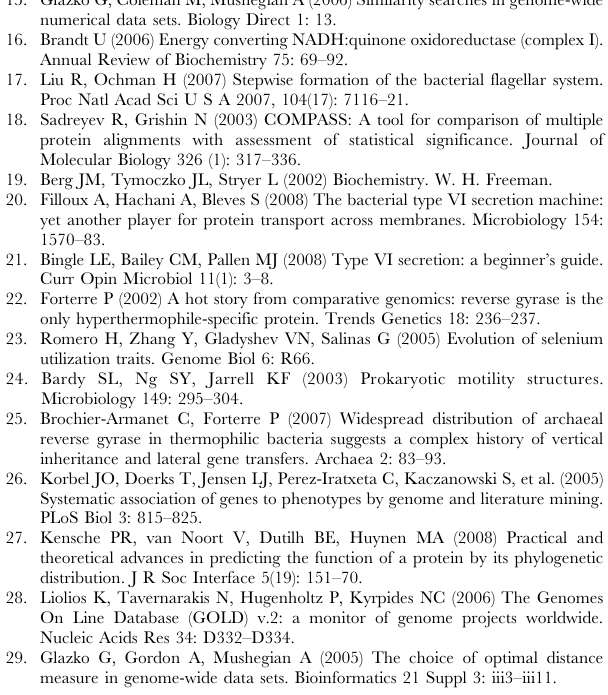
Table S4 Psi-square search results for cell motility phenotype.